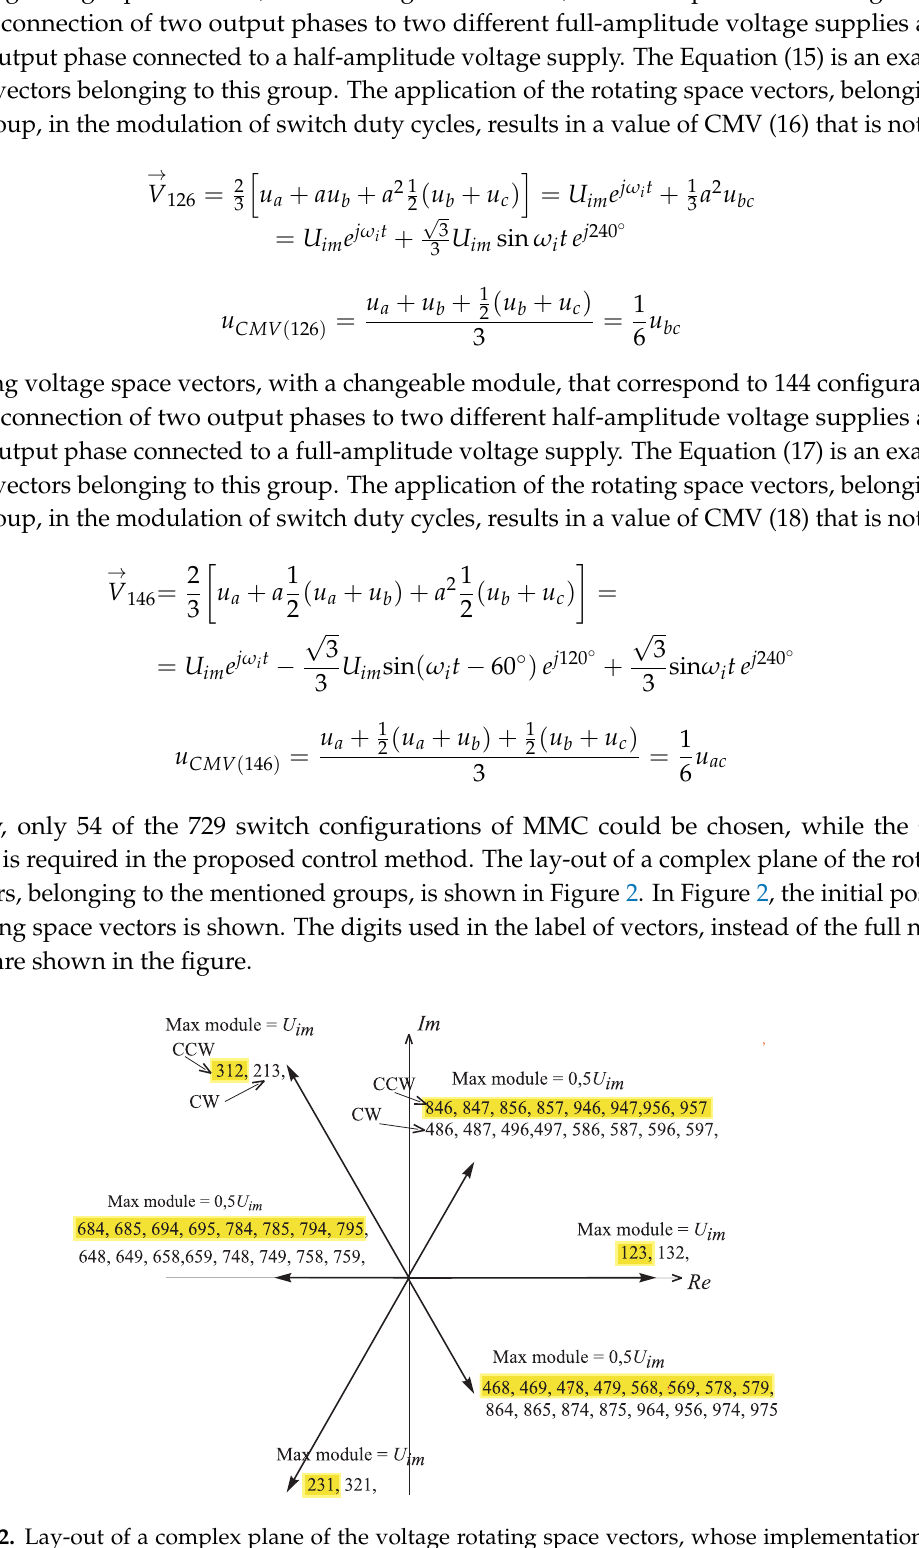
Figure 2. Lay-out of a complex plane of the voltage rotating space vectors, whose implementation assures the elimination of CMV.